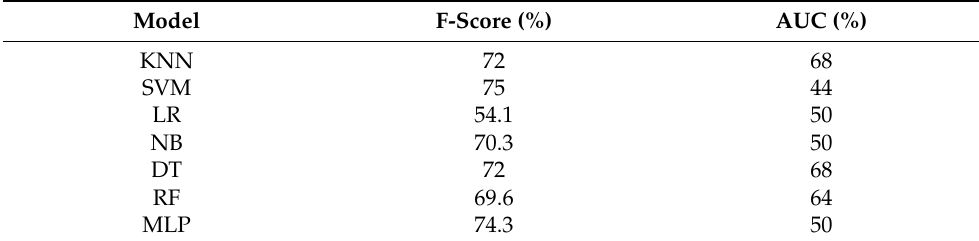
Table 8. Algorithmic performance for ‘Twitter with TextBlob’